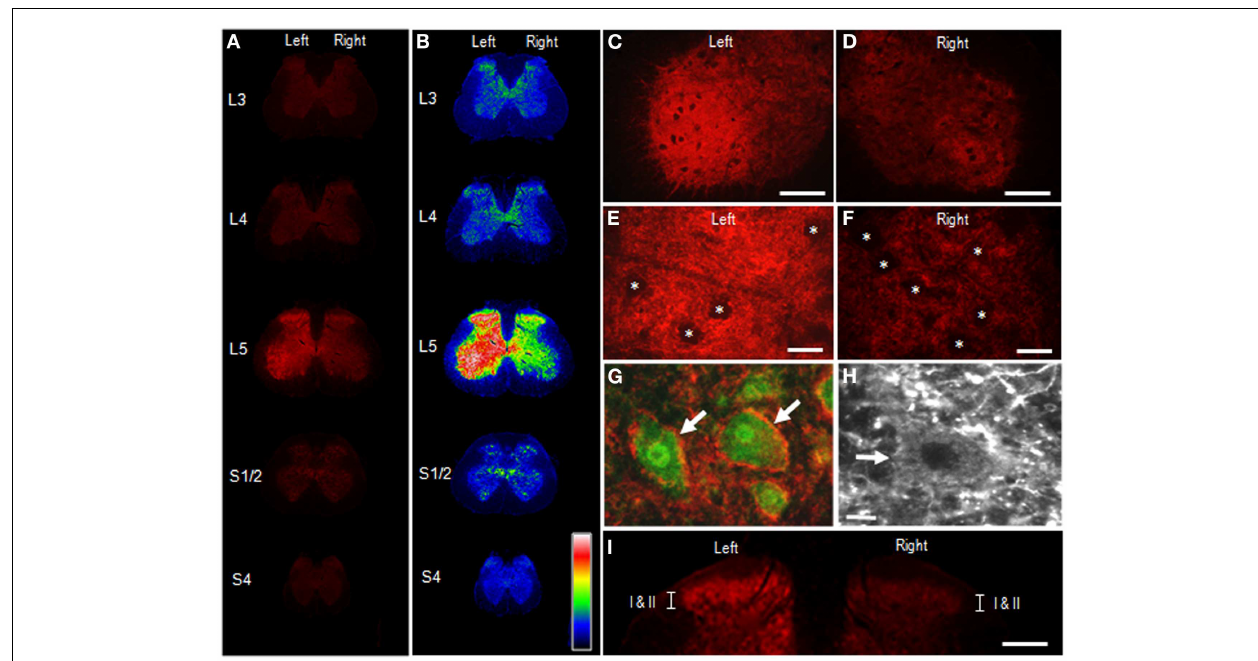
bars = 200 µ m. (E,F) Photomicrographs of the ventral horns (lamina IX) stained for ipsilateral (E) and contralateral (F) to peripheral toxin injection. Asterisks indicate spinal motoneurons. Scale bars = 50 µ m. (G) Photomicrograph of spinal motoneurons (arrows) doubly stained for ChAT (green) and cSNAP-25 (red) ipsilateral to peripheral toxin injection. Scale bar = 25 µ m. (H) High power-magnified photomicrograph with a longer exposure time showing a motoneuron (arrow) that exhibits cSNAP-25-immunoreactive puncta in its soma. Scale bar = 10 µ m. (I) Photomicrograph of the dorsal horns labeled for cSNAP-25, which contain lamina I and II (I/II). Scale bar = 400 µ